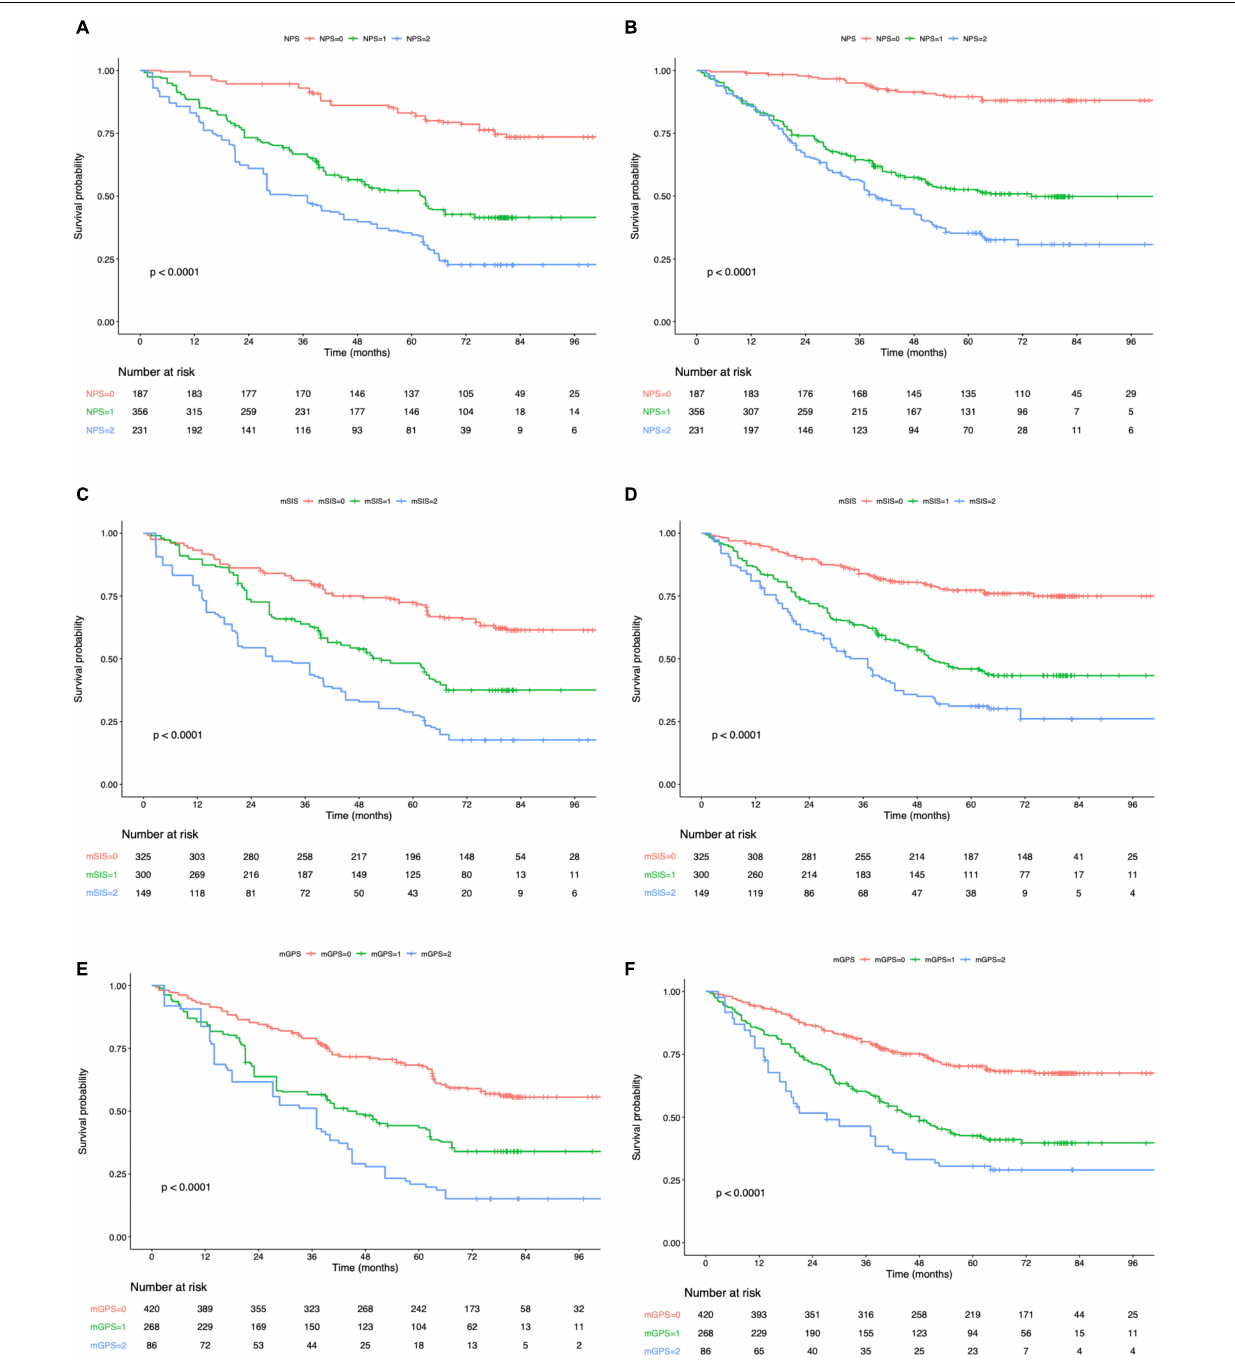
the tumor, resulting in cancer occurrence and development